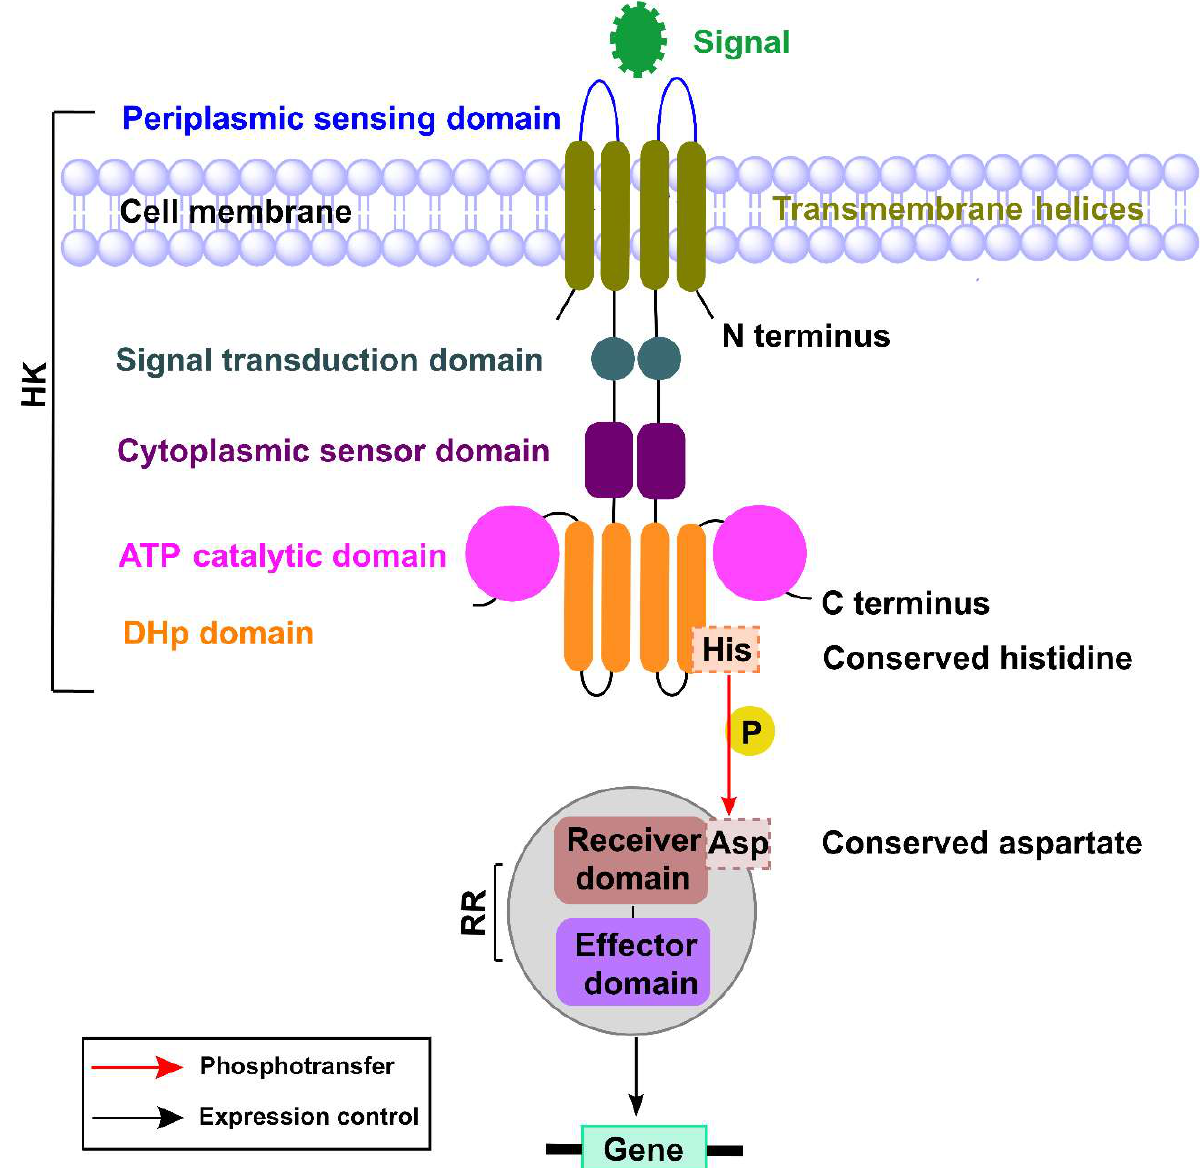
Figure 2. The basic mechanisms of a two-component signaling system. The sensor HK senses the environmental signal using the sensing domain that is connected to the signal transduction domain, a cytoplasmic sensor domain, an ATP catalytic domain, and a dimerization histidine phosphotransfer domain (DHp). The conserved histidine residue of HK transfers the phosphate to the conserved aspartate residue of the receiver domain of its RR. The effector domain of the phosphorylated RR binds to its target and regulates gene expression.